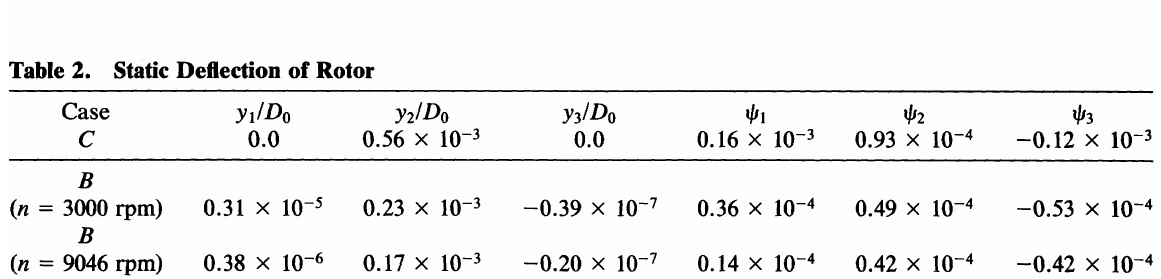
Table 2. Static Deflection of